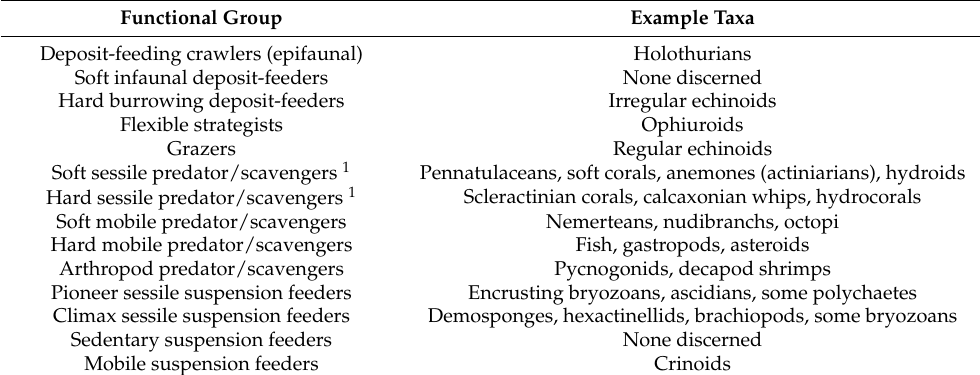
Table 2. Functional group categories (based on [94,95]) and example taxa discerned in Larsen C Ice Shelf Polynya (current